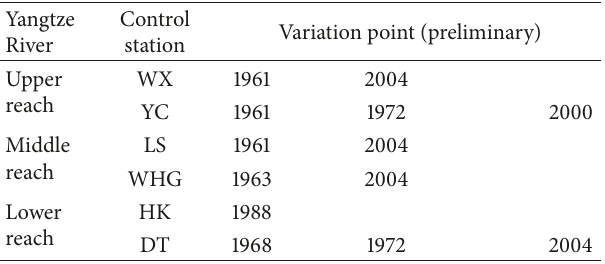
Table 4: Preliminary study of aberrance point by M-K test.